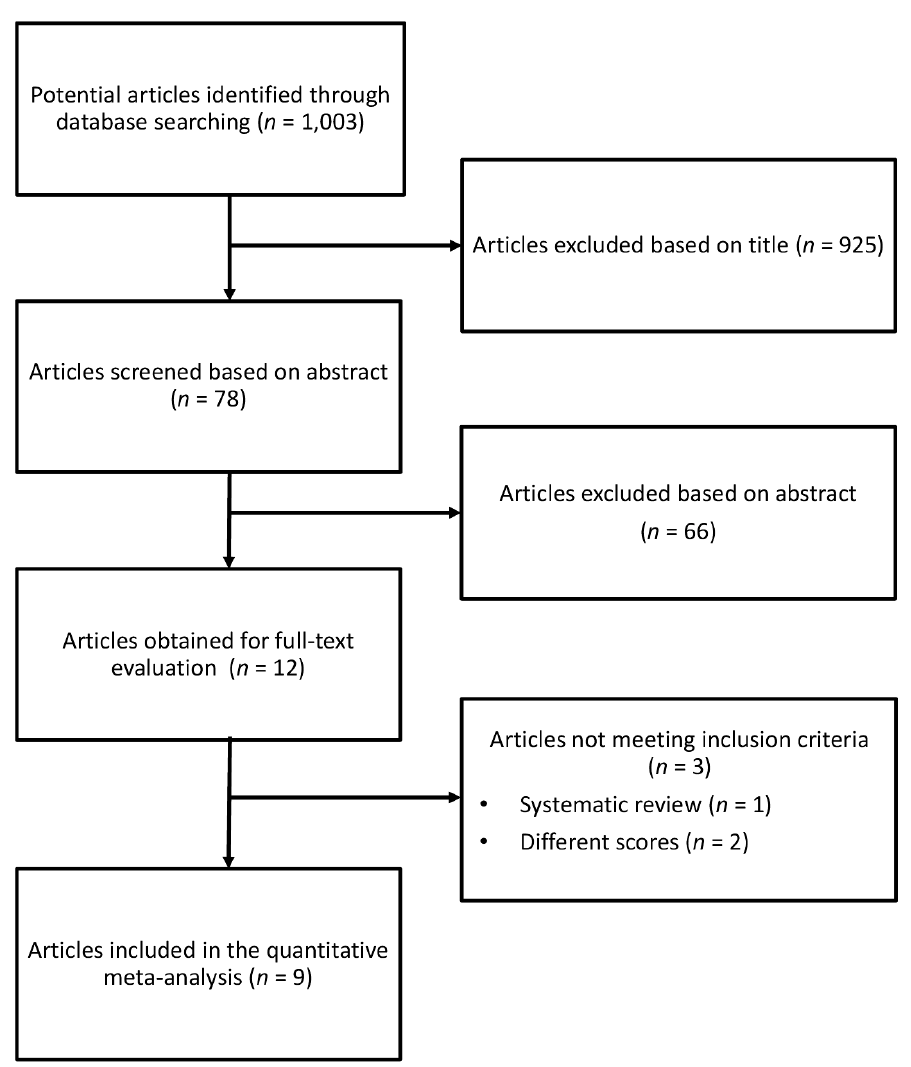
Figure 1. Flow chart and process selection of relevant studies exploring the association between Dietary Inflammatory Index (DII) and risk of colorectal, colon and rectal cancer.